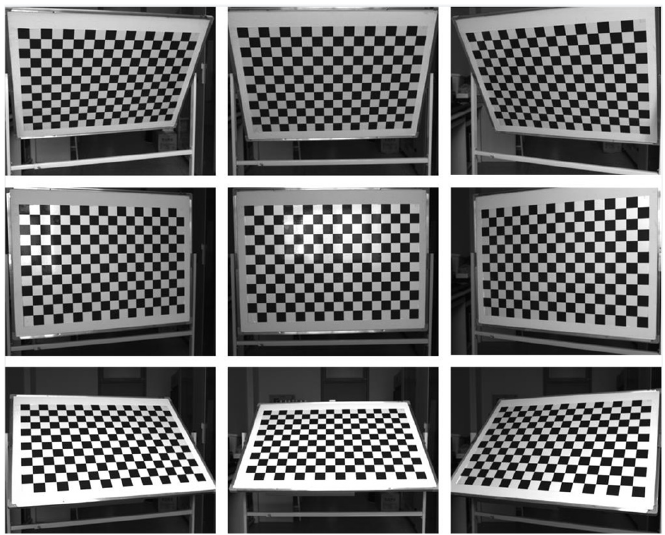
Figure 4. Chessboard images for camera calibration.